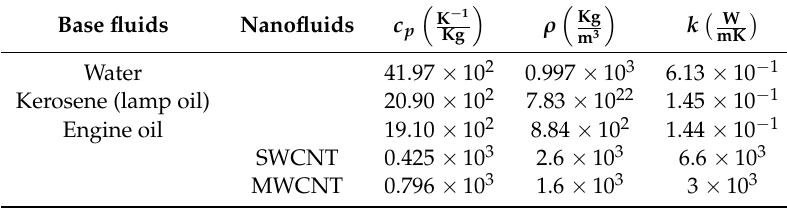
Table 10. Several physical characteristics of CNTs and different nanofluids.